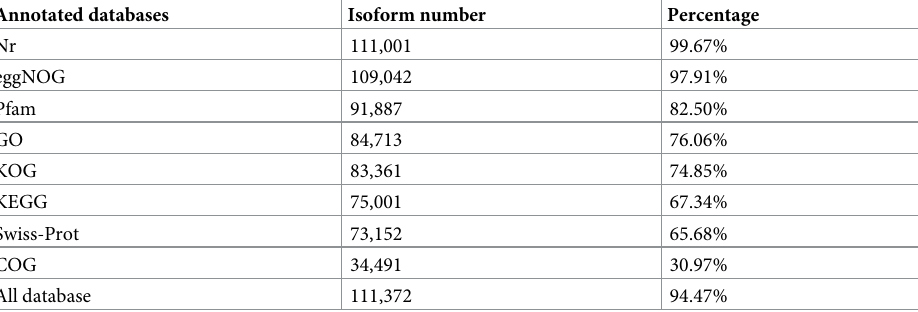
Table 3. Statistics of the annotation results.